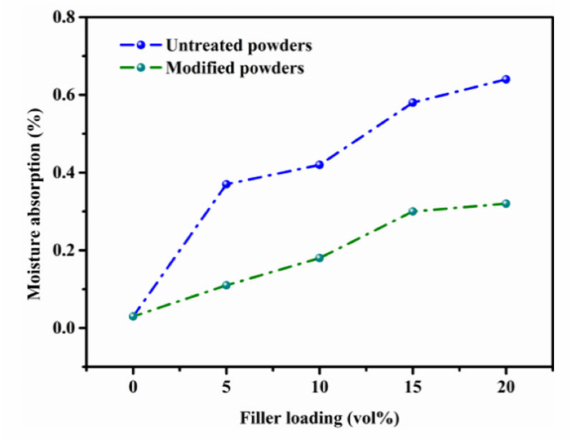
Figure 8. The water absorption of COC/Sr 2 CeO 4 and COC/Sr 2 CeO 4 @SiO 2 composites. To verify the corrosion resistance of the composites, the untreated and modified plates were placed in a solution of hydrochloric acid, sodium hydroxide and isopropanol